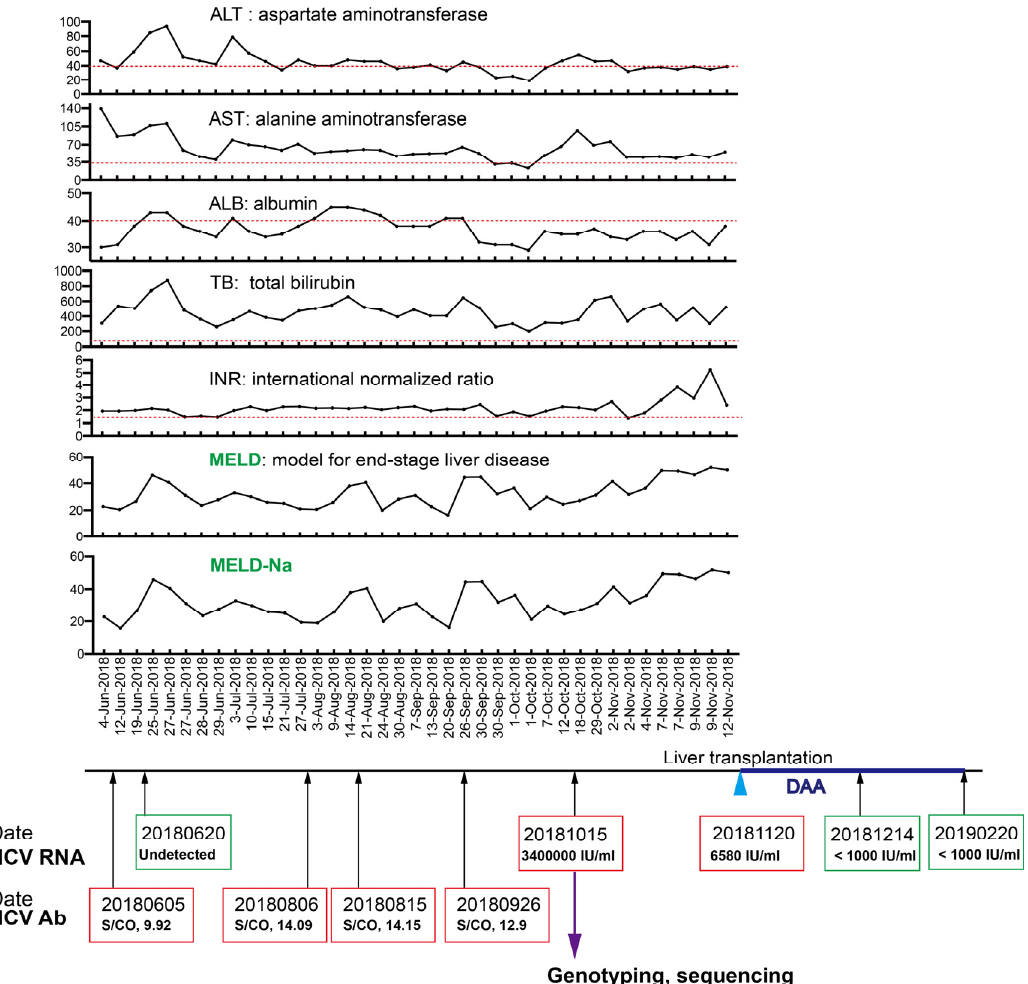
Figure 1. Clinical features of the hepatitis C patients. The aspartate aminotransferase (AST, upper limit of normal = 40 U/L), alanine aminotransferase (ALT, upper limit of normal = 35 U/L), albumin 9ALB, upper limit of normal = 35 U/L), total bilirubin (TB, upper limit of normal = 17.1 µ mol/L), international normalized ratio (INR, upper limit of normal = 1.5), model for end-stage liver disease (MELD) and the MELD-Na at each time point are presented. Red dashed lines indicate the upper limits of normal. Plasma viral RNAs were quantified at the indicated time points. Direct antiviral agent (DAA) treatment is shown in blue. Plasma samples (purple arrow) were applied for viral genotyping and sequencing. See details in the main text.